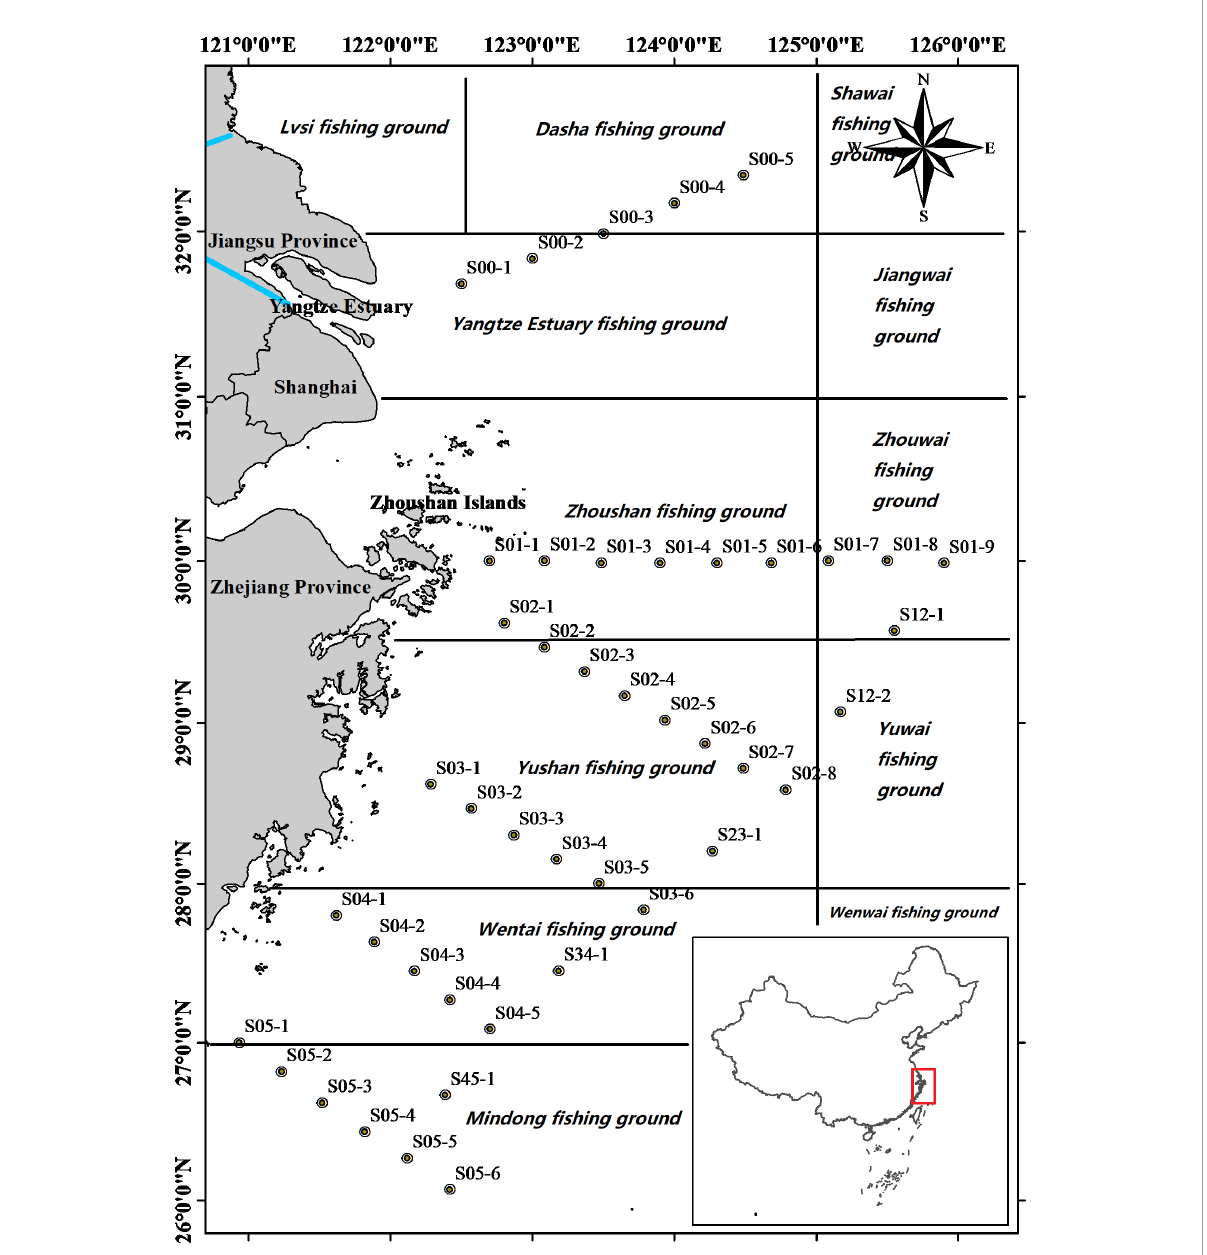
FIGURE 1 Map of sampling stations (black dots) of the East China Sea with adjacent provinces and fi shing grounds. The black points represent sampling sites. The blue line represents the Yangtze